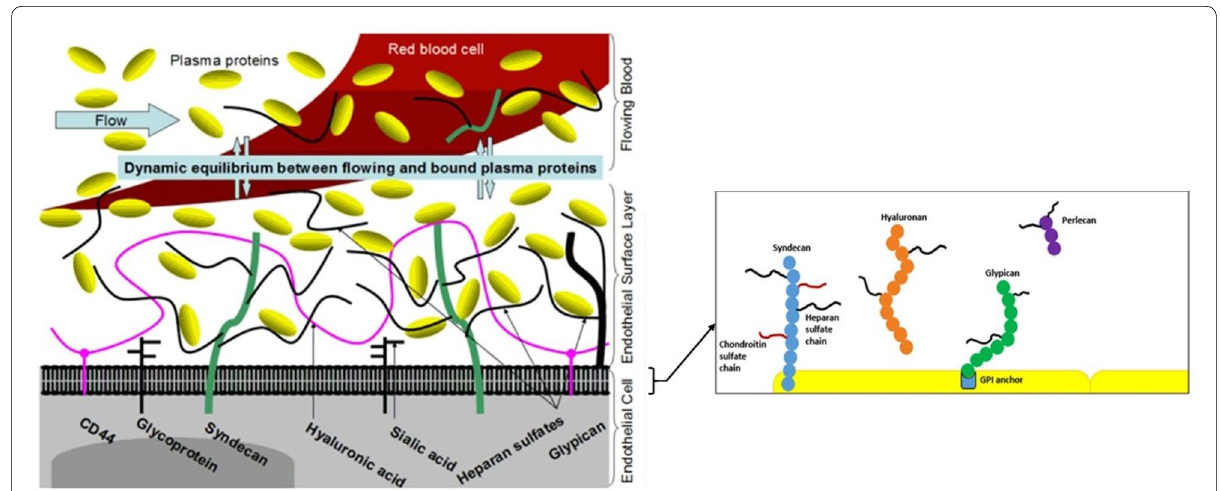
Fig. 1 Structure of the endothelial glycocalyx illustrating proteoglycans and glycosaminoglycans. Reproduced with permission from [4]. GPI glycosylphosphatidylinositol